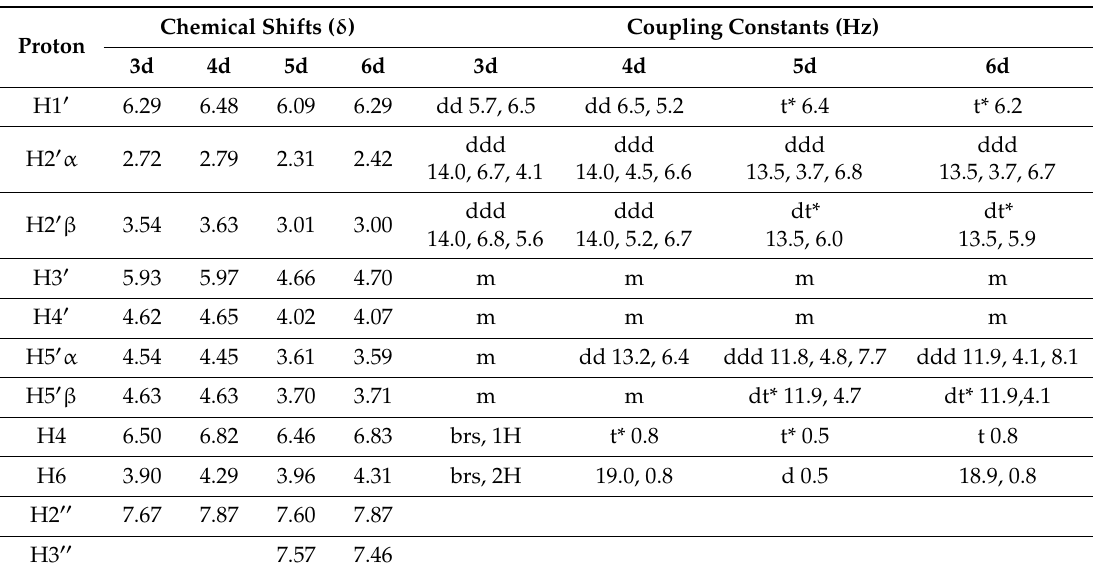
Table 2. Chemical shift and coupling constants from the 1 H-NMR of compounds 3d , 4d , 5d, and 6d in acetone- d 6 . a Please refer to structures in Table 4 for skeleton